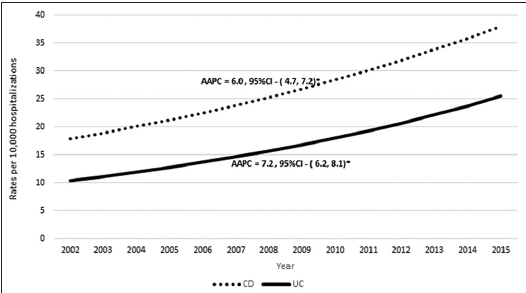
Figure 1: Annual incidence of hospitalization for Crohn’s disease (CD) and ulcerative colitis (UC) from 2002-2015 AAPC= Average Annual Percent Change. (Table 2). For both CD and UC patients, the rate of open, laparoscopic and other partial excision of the large intestine decreased significantly over time (Supplemental Figure 3), while other operations did not change. The rate of anastomotic leak decreased for CD (Supplemental Figure 4A) and increased for UC patients (Supplemental Figure 4B), however, these trends did not reach statistical significance.